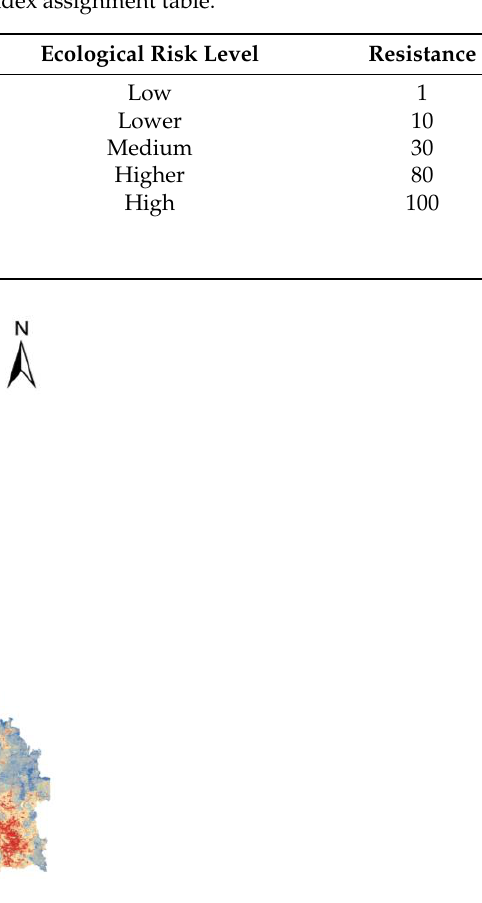
Figure 8. Spatial distribution of comprehensive resistance.